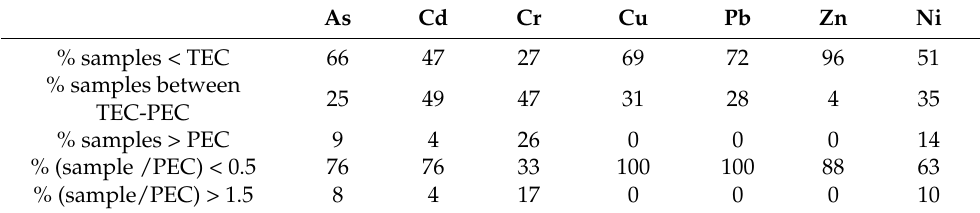
Table 5. Comparison between heavy metal concentrations (mg · kg − 1 ) of all samples with sediment quality control guidelines and PEC ratio